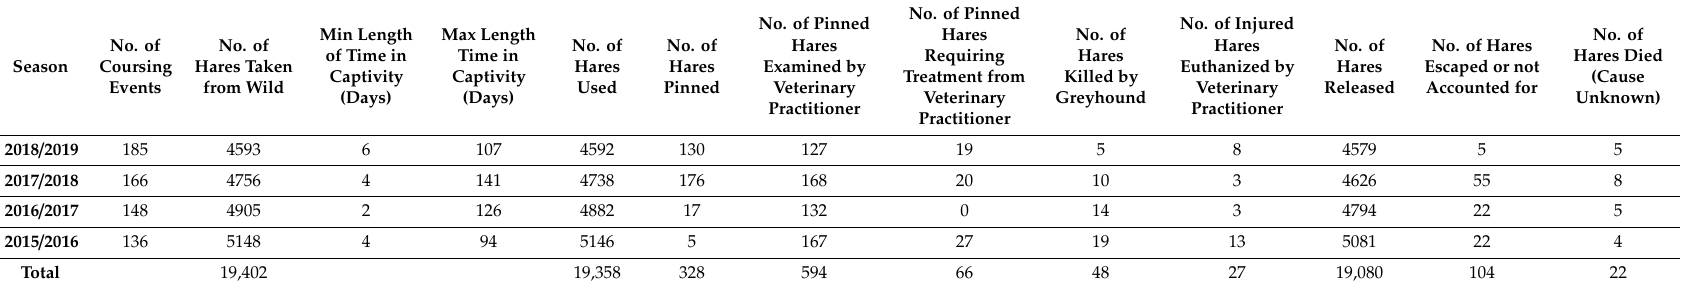
Table 2. Details of the numbers of hares netted and taken from the wild for hare coursing in Ireland over four hare coursing seasons, the number of coursing events, time in captivity and fate of hares